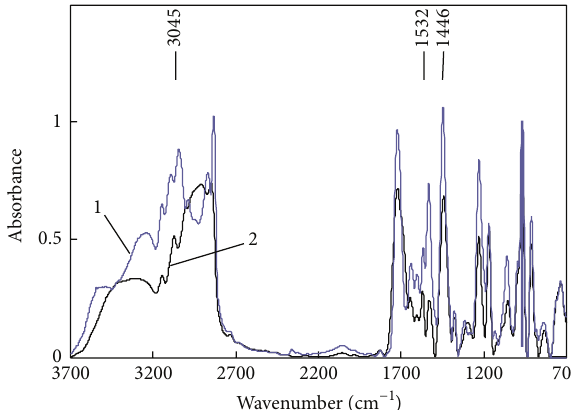
Figure 5: FTIR-spectrum of reaction mixture “1-butyl-3-methyli- midazolium bromide-PDI-3AK”: (1) initial mixture; (2) kept for 5 h at 100 ∘ C.